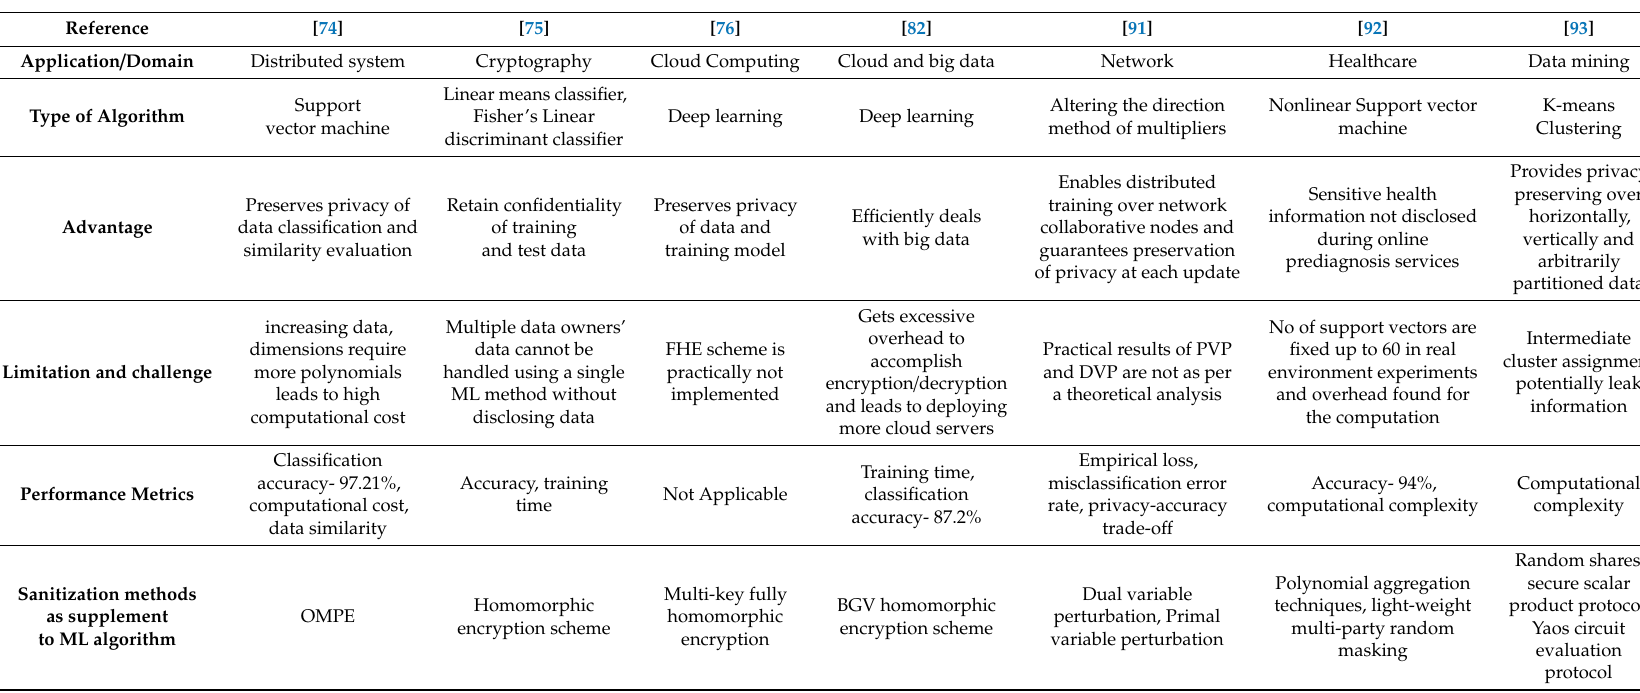
Table 7. Review of Privacy Preserving techniques (Notations: OPME-Obvious Evaluation of Multivariate Polynomial,